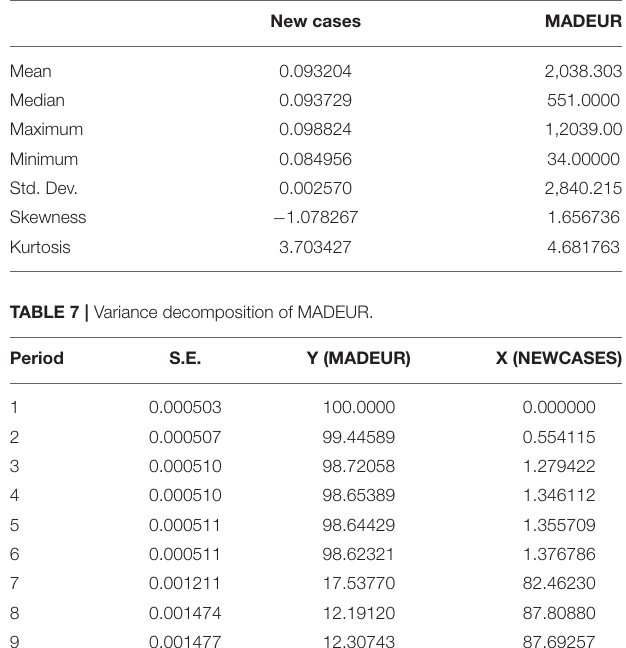
TABLE 6 | Descriptive statistic for COVID-19 new cases and MADEUR exchange rate.